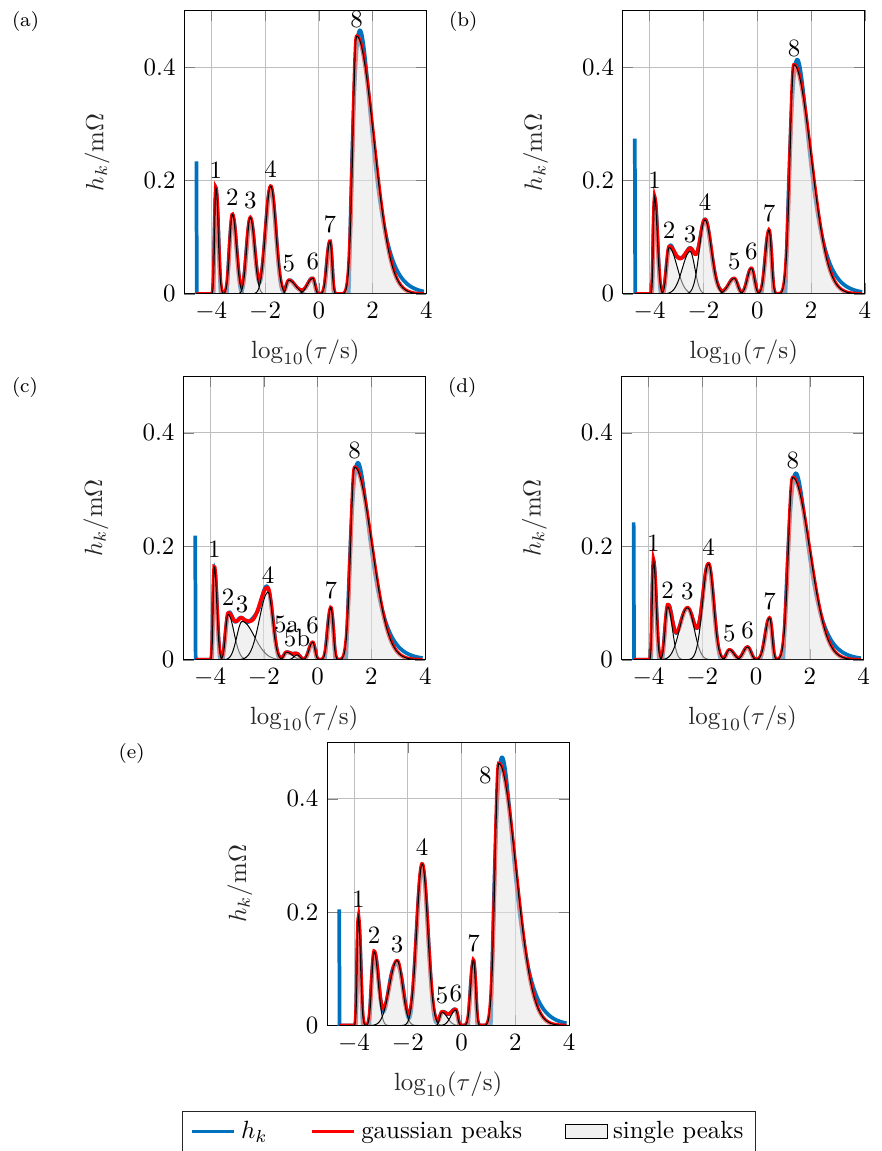
Figure 8. Non-normalized DRT with peak analysis for ( a ) 100% SOC , ( b ) 80% SOC , ( c ) 60% SOC , ( d ) 40% SOC , ( e ) 20% SOC